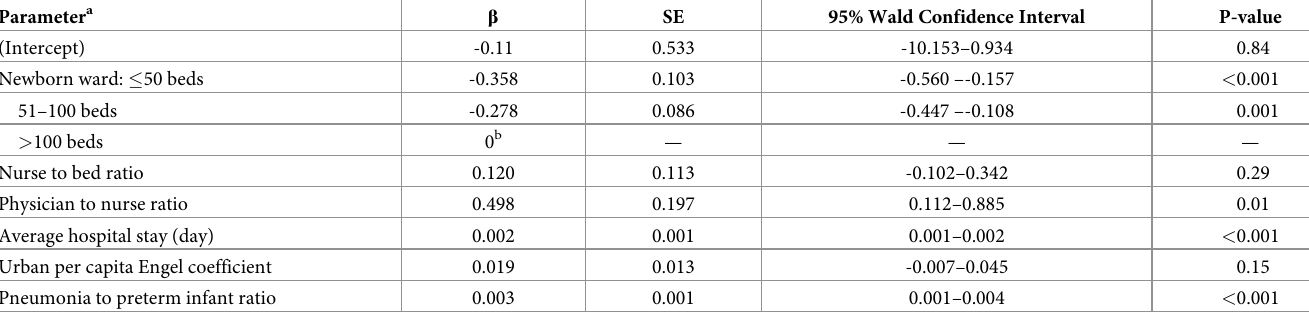
Table 3. Results of generalized estimating